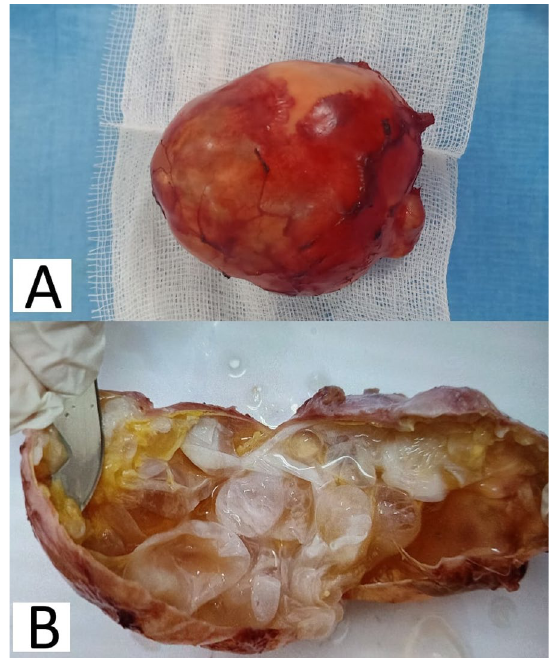
Fig. 3 Intraoperative photos showing A Fully intact extracted cyst 7 cm in diameter B Several daughter cysts within the cyst after dissecting